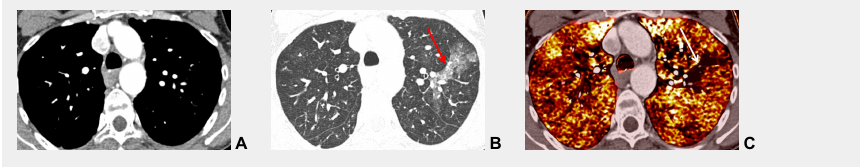
Eisenmenger’s syndrome secondary to a large ventricular septal defect. No vascular abnormalities were seen ( A ) but some ground-glass opacities (arrow) ( B ) with the absence of perfusion corresponded to vascular ground-glass opacities surrounded by clear heterogeneous pulmonary perfusion ( C ).